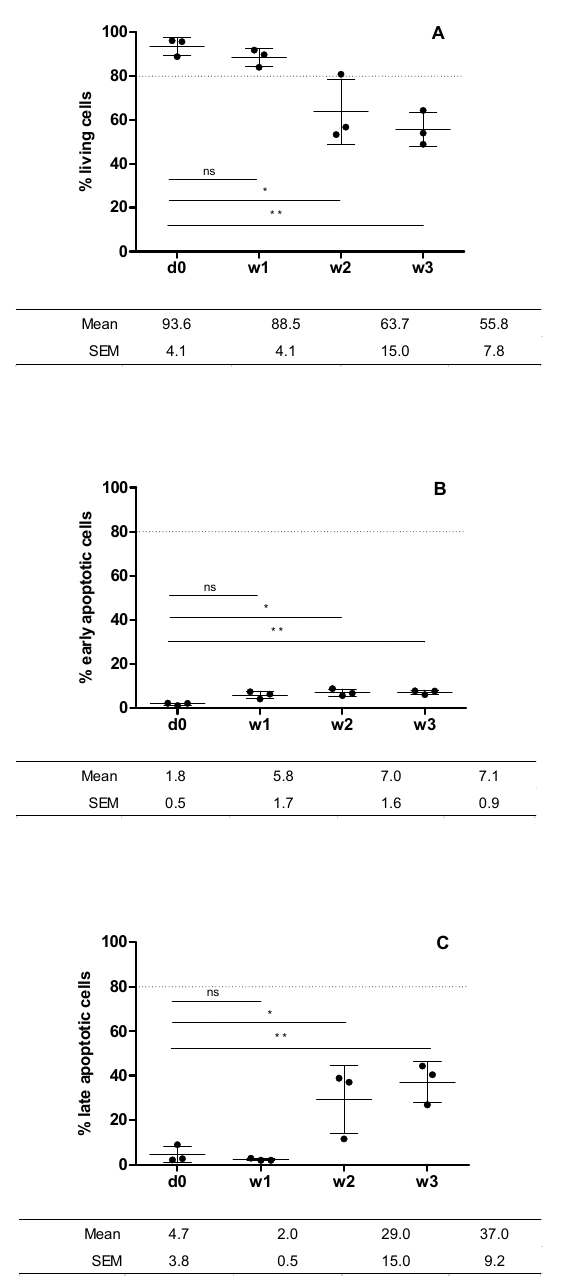
8 of 14 Figure 3. Flow cytometry analysis of cell viability of cartilage preserved at day 0, and at weeks 1, 2 and 3. Channels shown: calcein (B530-A), 7-AAD (B695-A) and Annexin V (R660-A). Plots shown: